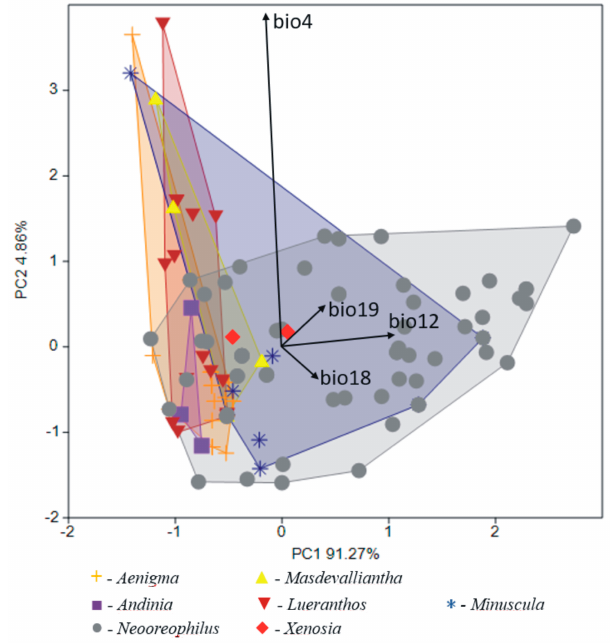
Figure 8. Principal component analysis (PCA) of the climatic variables present in the studied genera among the Andinia -complex. Variables with the greatest contributions are presented as vectors.